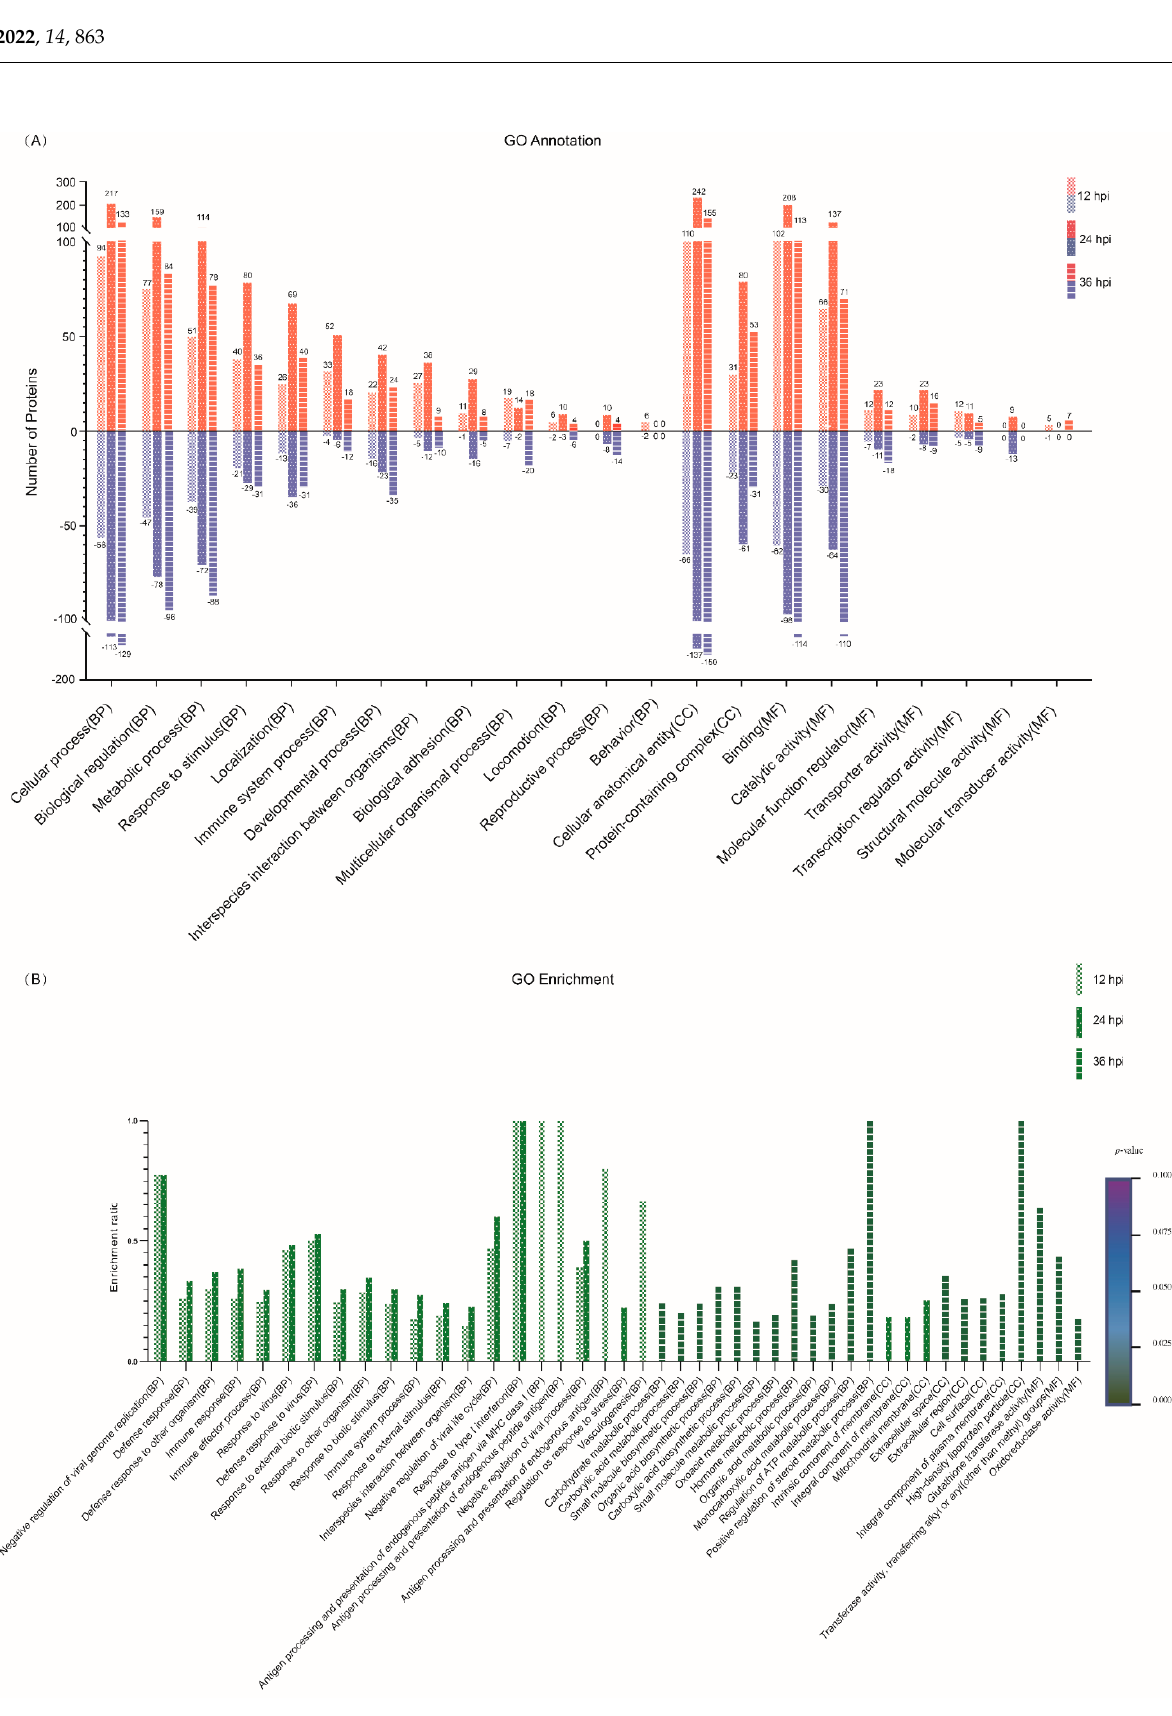
Figure 3. Gene ontology (GO) functional annotation for the DEPs identified in PK-15 cells in response to SVA infection. ( A ) The top 20 GO terms with the most DEPs at 12, 24 and 36 hpi, respectively. The relevant DEPs were classified into 22 subclasses under the three major GO categories of biological process (BP), cellular component (CC) and molecular function (MF). The abscissa texts